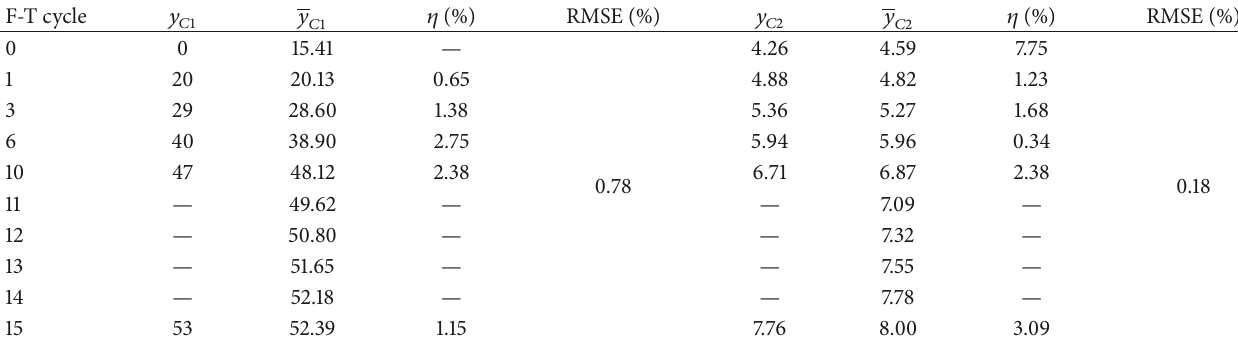
Table 10: Prediction results of 𝑦 𝐶1 and 𝑦 𝐶2 for CRSMA based on regression model.